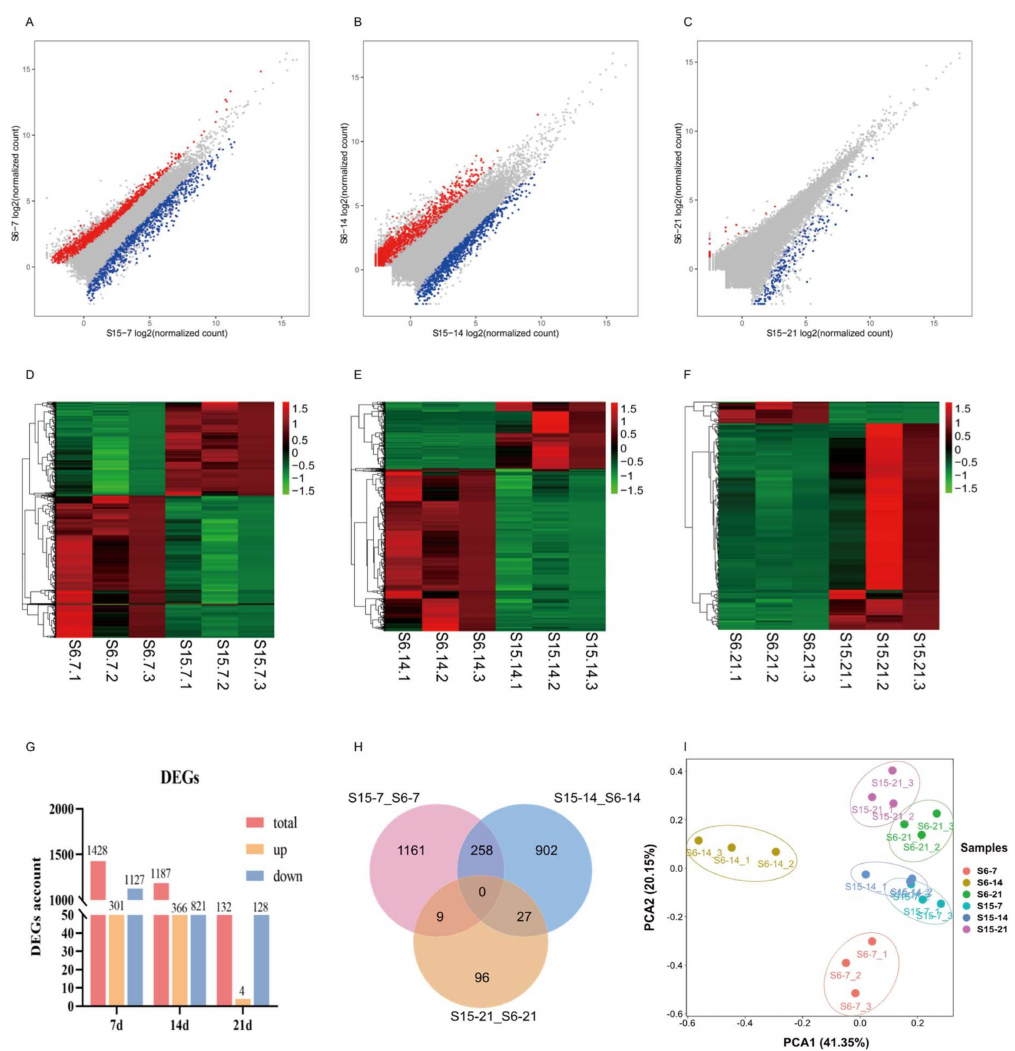
Figure 2. Effects of hypotonic stress at different development stages of M. rosenbergii post-larvae on gene expression. Note: ( A – C ): the scatter plots showed the differences of gene expression of hypotonic stress in 7, 14, 21 day-post-hatch larvae, respectively; Red represents upregulated genes, blue represents downregulated genes; ( D – F ): the heatmap showed differential gene expression of hypotonic stress in 7, 14, 21 day-post-hatch larvae, respectively; Red represents upregulated genes, green represents downregulated genes; ( G ): the histogram showed the counts of different expression genes in different group; ( H ): Venn diagram comparing the expression distribution of different expression genes; ( I ): Principal component analysis (PCA) for the correlation among samples in different group. S6-7: 7 day-post-hatch larvae in 6 psu salinity; S15-7: 7 day-post-hatch larvae in 15 psu salinity; S6-14: 14 day-post-hatch larvae in 6 psu salinity; S15-14: 14 day-post-hatch larvae in 15 psu salinity; S6-21: 21 day-post-hatch larvae in 6 psu salinity; S15-21: 21 day-post-hatch larvae in 15 psu